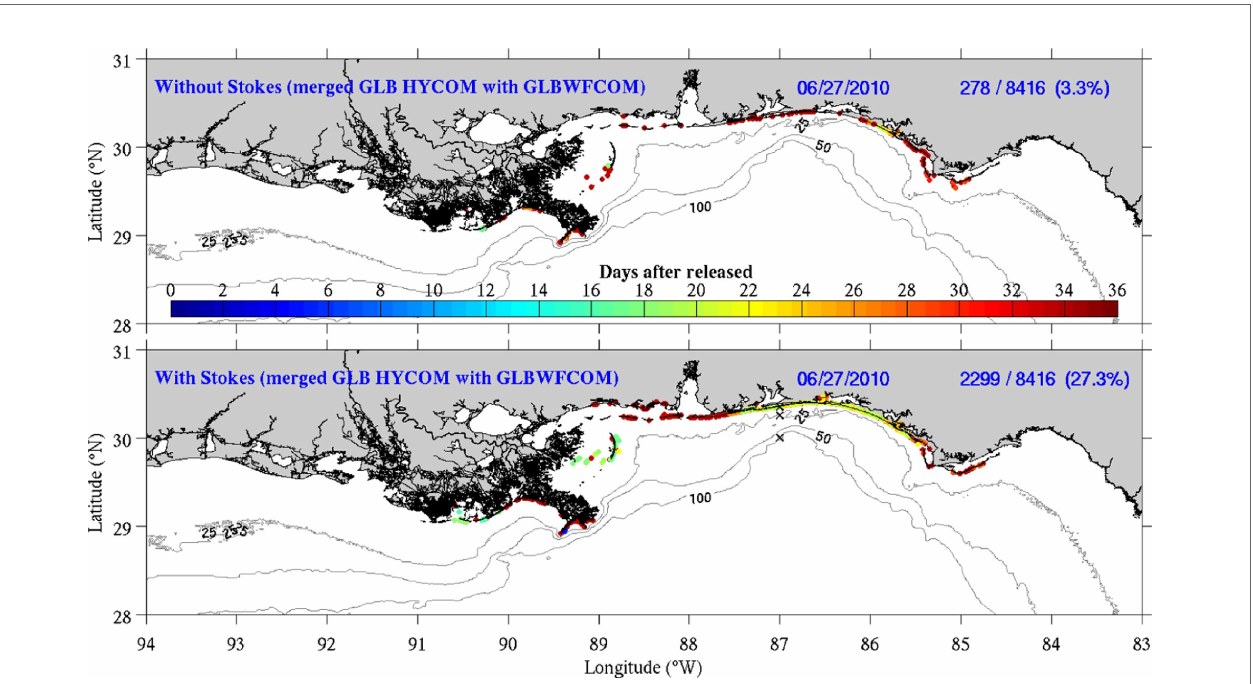
FIGURE 13 | Distribution of beached surface particles and their (color-coded) ages on June 27, 2010 for the case of the Global HYCOM merged with the WFCOM nested in the Global HYCOM, either without (top panel) or with (bottom panel) Stokes drift added. Bathymetric contours are in m. The number of beached particles, relative to the total number (8416) of particles released, and the percent of particles beached are provided in the upper right (from Weisberg et al.,